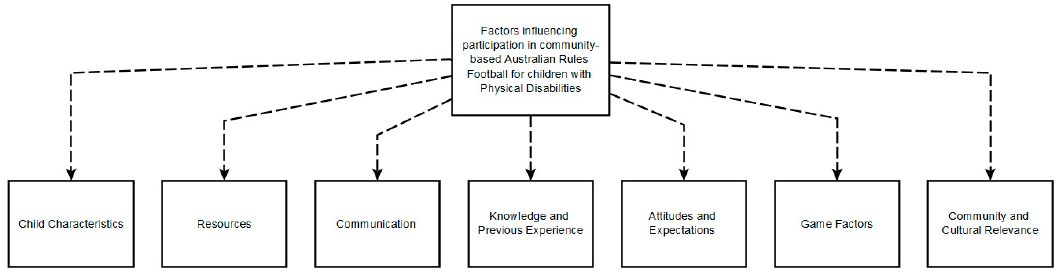
Figure 1. Themes arising from qualitative analyses relating to factors influencing participation in community-based Australian Rules Football for children with physical